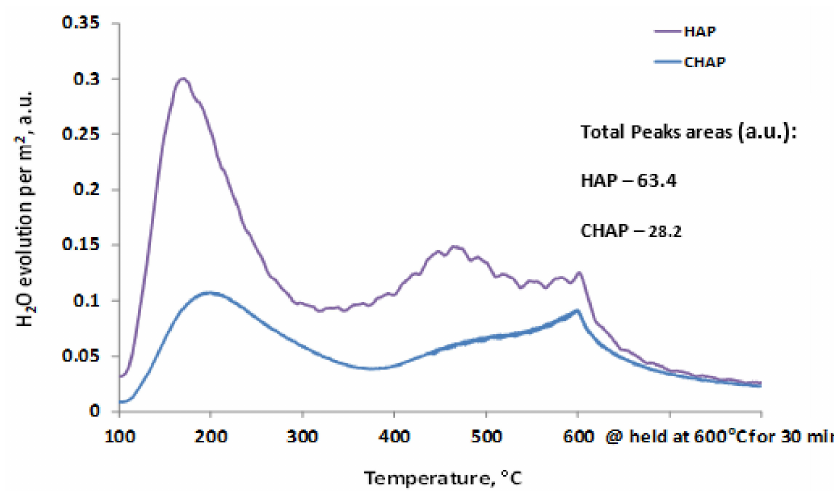
Figure 5. H 2 O-TPD (Thermo-Programmed Desorption) spectra of HAP and C-HAP materials.